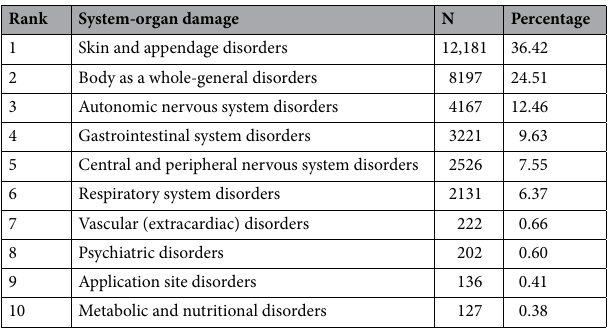
Table 4. Number and percentage of ADRs related to system-organ damage (top 10, n = 33,446).